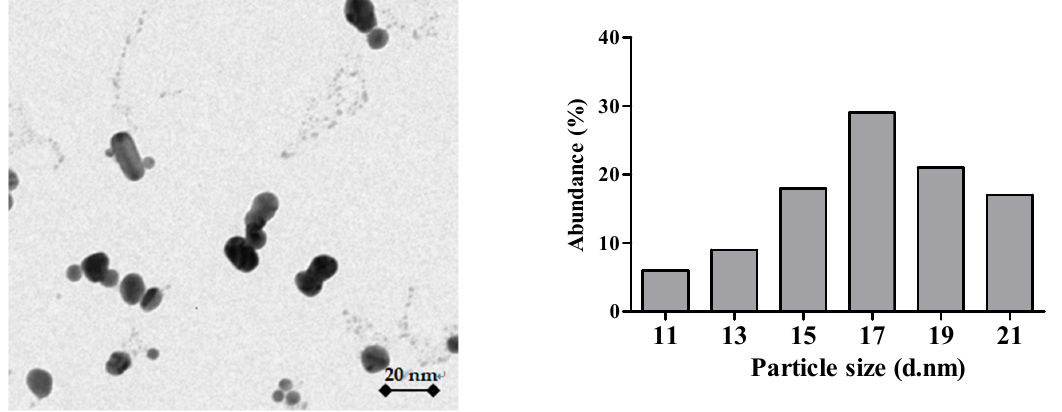
Figure 1. TEM image of AgNPs and its particle size distribution histogram.